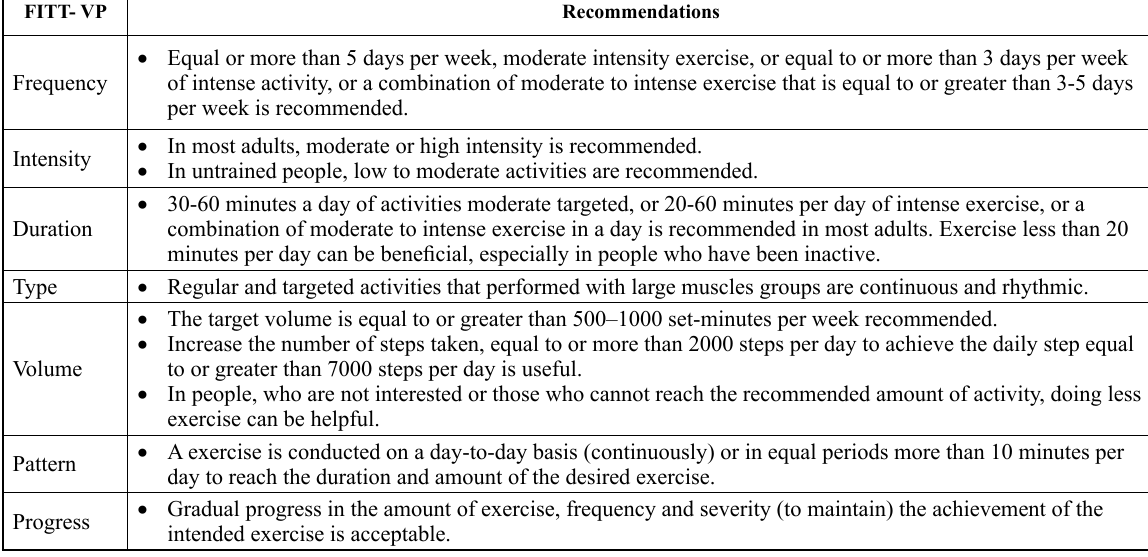
Table 3. Recommendations based on aerobic